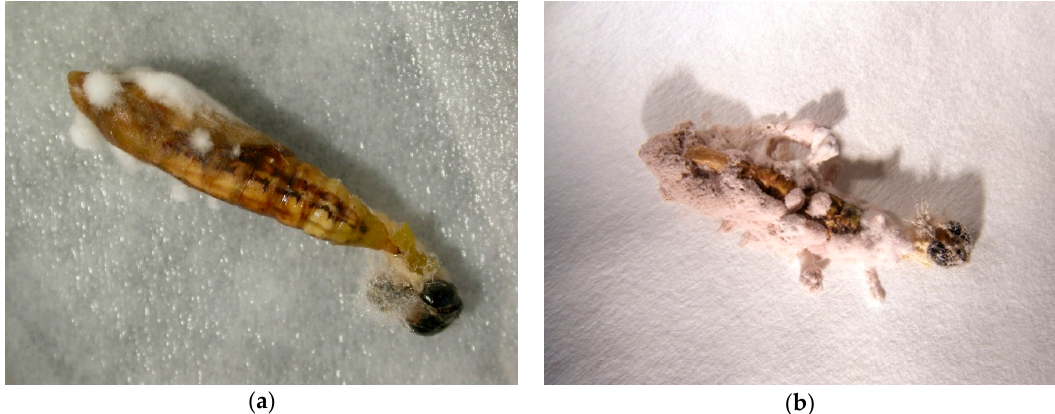
Figure 1. ( a ) Early mycosis of Isaria fumosorosea on Cydalima perspectalis pupa; ( b ) Cadaver of C. perspectalis covered with sporulating fungus.